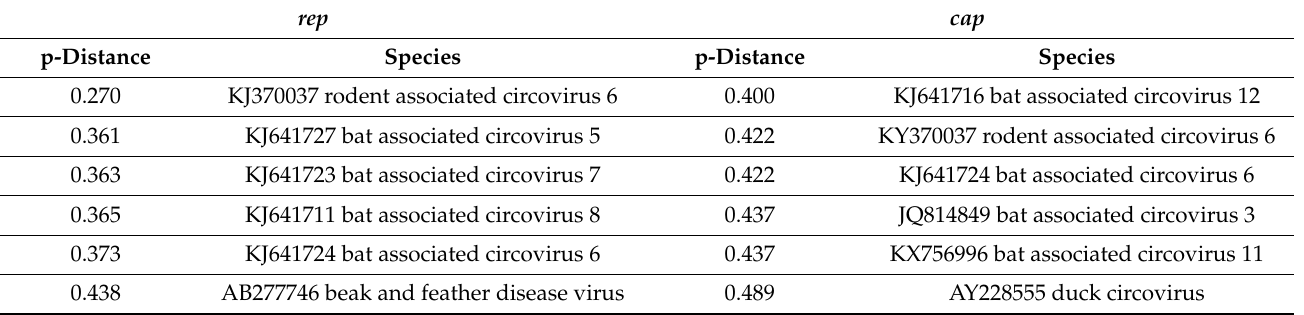
Table 1. List of the five species closest to ToCV at rep and cap level, along with the closest avian circovirus. The pairwise p-distance estimation was conducted after aligning the rep and cap sequences of the 50 representatives of the genus Circovirus at codon level with the MUSCLE